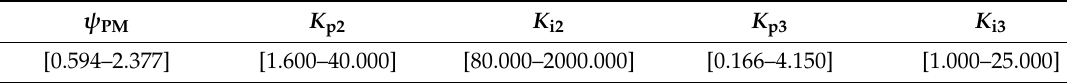
Table 5. Identification intervals of parameters. PM ψ